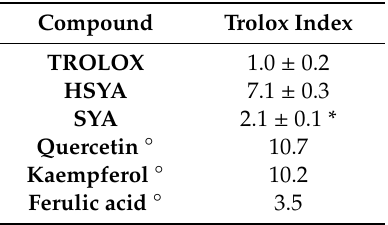
Table 1. Trolox index values for hydroxy sa ffl or yellow A (HSYA) and sa ffl or yellow A (SYA). * p < 0.005 vs. HSYA; ◦ Data from literature